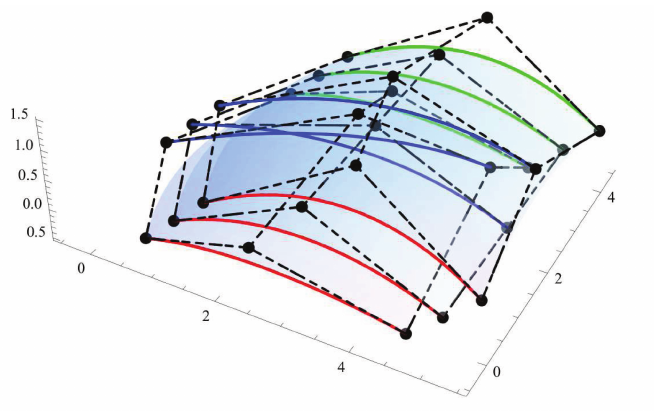
Figure 2. Fuzzy u